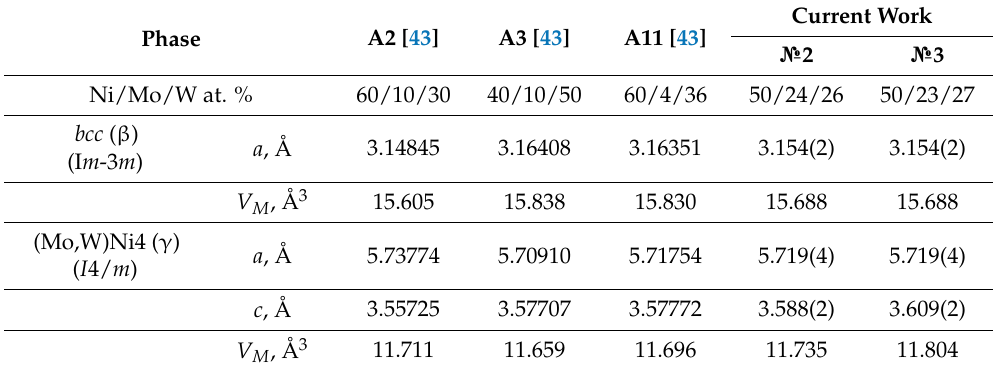
Current Work № 2 № 3